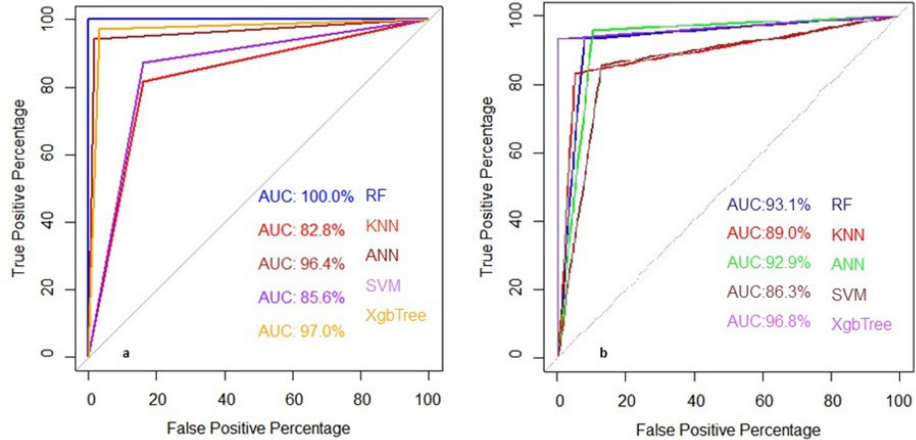
Figure 8. ROC curves showing AUC of RF, KNN, ANN, SVM, and XgbTree models ( a ) training dataset and ( b ) validation dataset.